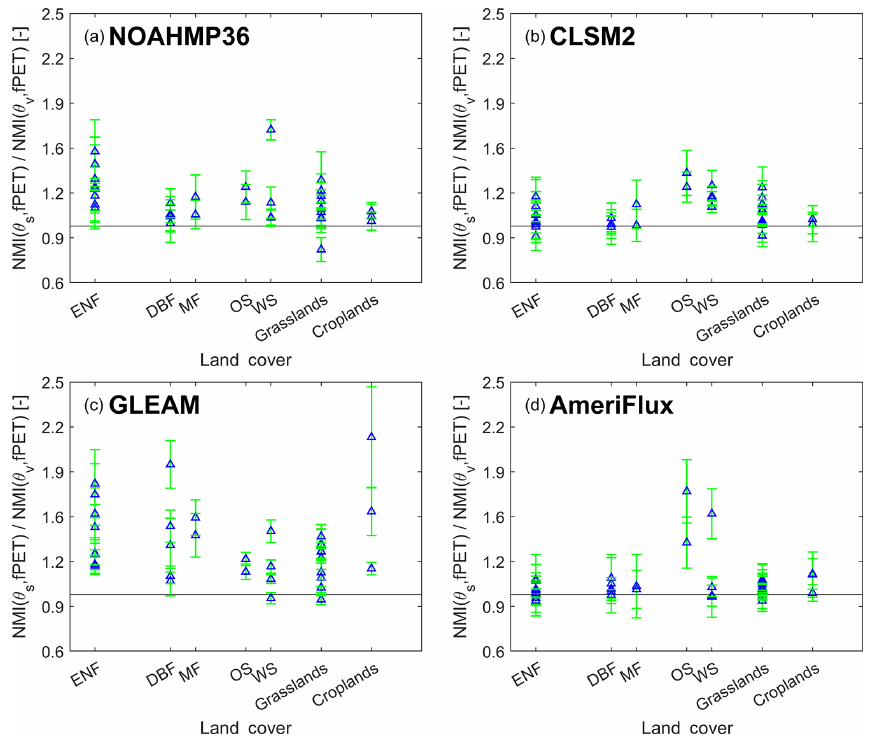
Figure A1. For (a) NOAHMP, (b) CLSM, (c) GLEAM and (d) AmeriFlux estimates, the ratio of NMI( θ s , fPET) and NMI( θ v , fPET) as a function of vegetation types across all AmeriFlux sites. “ENF”, “DBF”, “MF”, “OS” and “WS” represent evergreen needleleaf forests, deciduous broadleaf forests, mixed forests, open shrubland, and woody savannas,